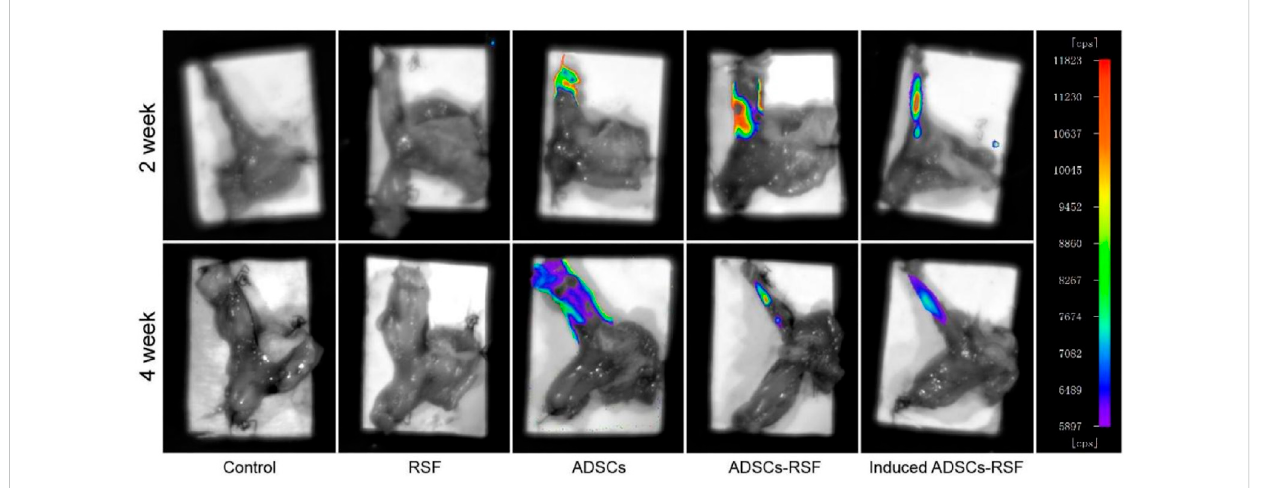
FIGURE 3 ToinvestigatetheengraftmentofADSCs,simpleRSF,theADSCs,theRSFmixedwithADSCs,orRSFmixedinducedADSCswereinjectedintotheLES of rats. Small animal imaging technology observed that ADSCs emitted fl uorescence in the second week, and the fl uorescence area gradually decreased in the fourth